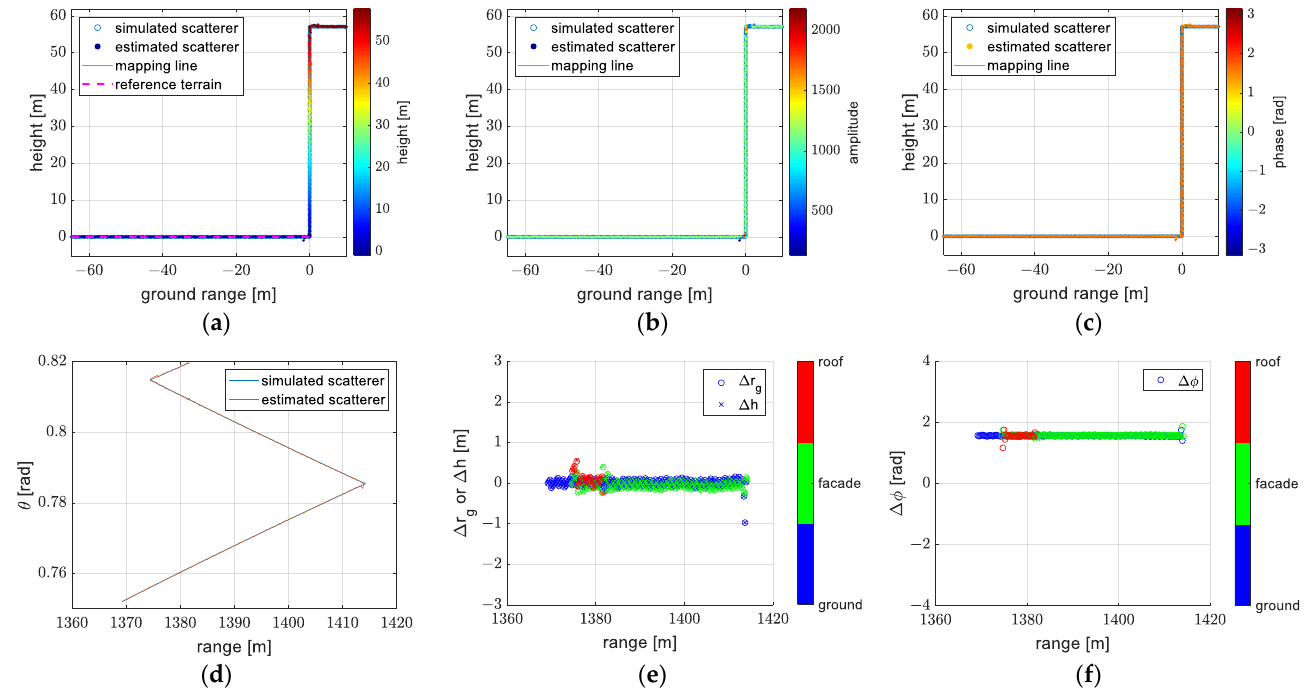
Figure 14. The reconstruction obtained using model 5 (the exact form of the spherical wavefront model): ( a ) reconstruction with colors denoted as height, ( b ) reconstruction with colors denoted as amplitude, ( c ) reconstruction with colors denoted as phase, ( d ) the off-nadir angle of the reconstruction, ( e ) the error of the ground range and height, ( f ) the error of the phase.